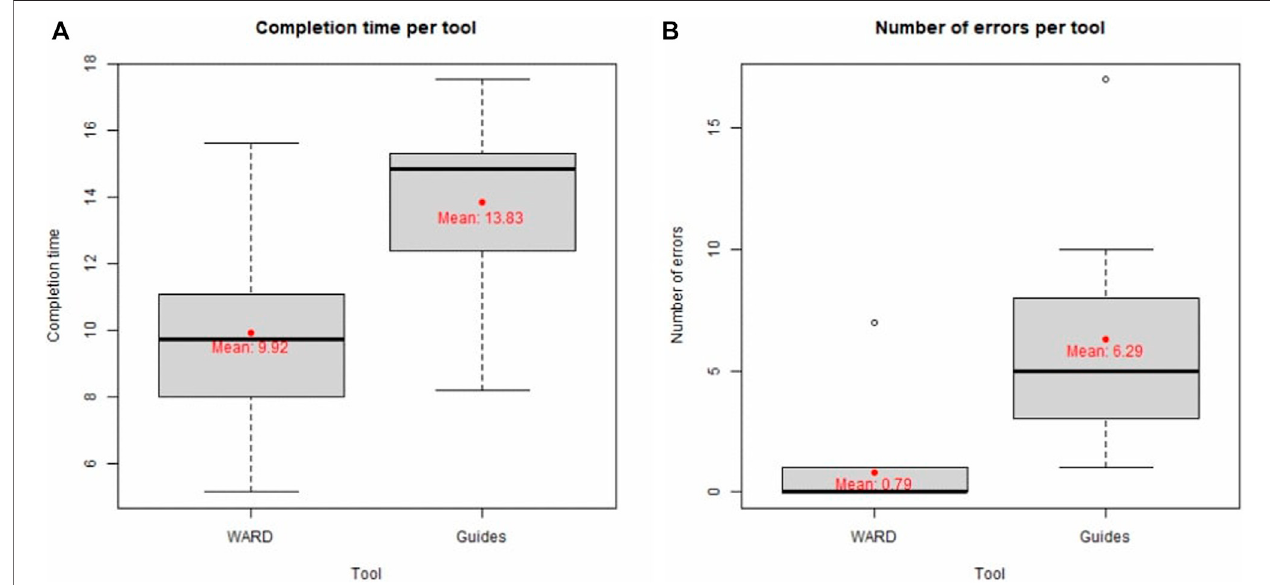
FIGURE 8 | (A) Comparative boxplots of the time per tool with means in red showing that the completion time is longer with Guides, (B) Comparative boxplots of the number of errors per tool with means in red showing that operators make fewer errors with WARD.